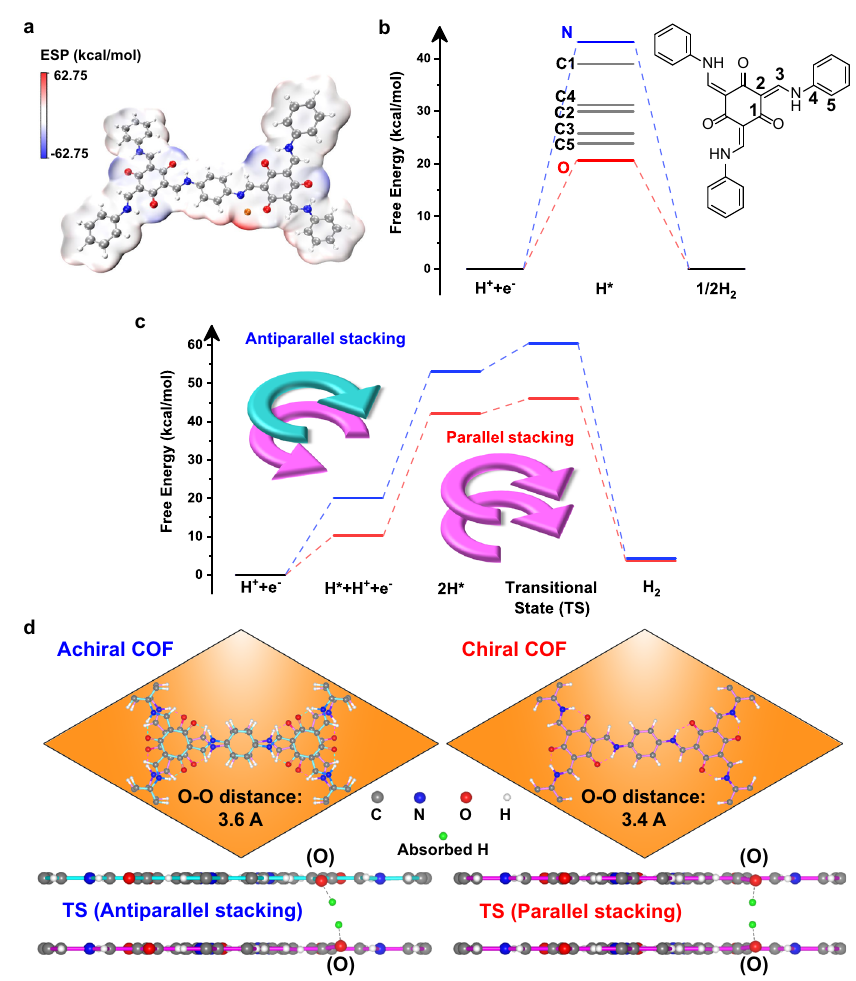
Fig. 5 | Proposed kinetic mechanism of H2 production on the TpPa-Cu-COF. a Electrostatic potential (ESP) of the TpPa-Cu(I) model. b Calculated binding free energy of H atom on the TpPa model. c Schematic Gibbs free energy diagrams for